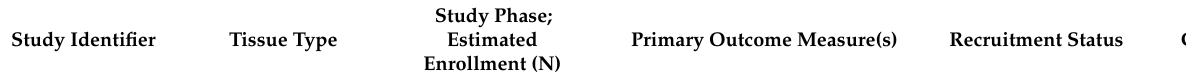
Table 1. Clinical trials registered on ClinicalTrials.gov till 1 March 2022 utilizing amniotic tissue for treatment of knee